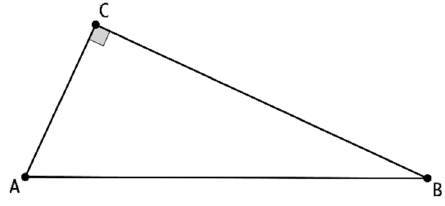
Figure 1. The drawing provided by the